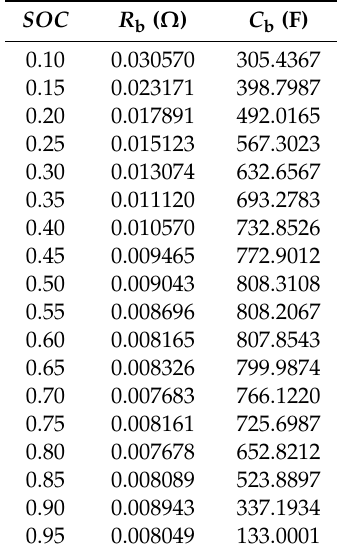
Table 1. The identification results of R b and C b with di ff erent state of charge ( SOC